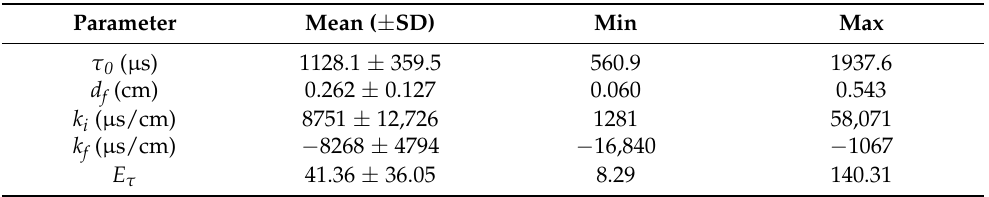
Table 3. Mean, minimum, maximum values and standard variation of parameters τ 0 , d i , d f , k i , k f and E τ describing the evolution of τ as a function of d for bones